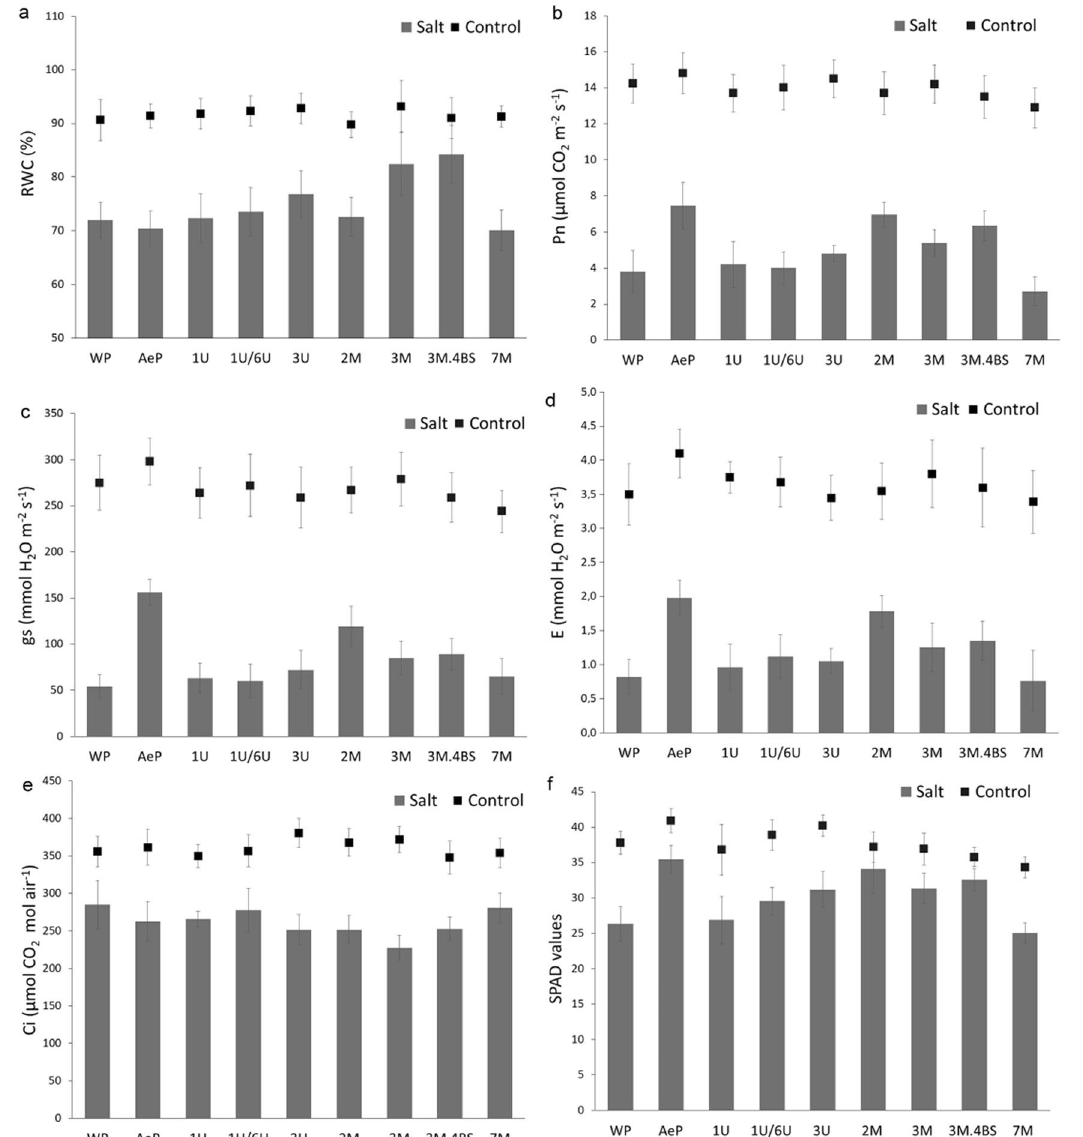
Figure 4. Relative water content (RWC) ( a ), photosynthetic activity (Pn) ( b ), stomatal conductance (gs) ( c ), transpiration rate (E) ( d ), interneccular CO2 level (Ci), ( e ) and chlorophyll content indicated by SPAD values ( f ) in leaves with and without salt treatment. WP: wheat parent; AeP: Aegilops parent. Data represent mean ± standard deviation of 5 replicates per treatment and genotype for RWC, Pn, gs, E and Ci, while n = 10 for determination of SPAD values in each treatment. The results of statistical analysis using Tukey’s post hoc test are presented in Supplementary Table 3M.4BS addition lines and the lower salt-induced changes both in the roots and in the shoots indicated a bet- ter root and shoot growth potential under salt stress condition. In the case of 2M and 3M addition lines, better growth was manifested only under salt stress conditions. Similar trends were observed for the changes of root and shoot weight (Supplementary Fig. S1). Wilting of leaves is one of the most obvious symptoms of salt-induced osmotic stress, indicating a disturbance in water balance 39 . In the present study, the RWC of the leaves was similar in all plants grown in hydroponic solution without salt stress, while RWC decreased significantly under salt stress condition in most genotypes, except for 3M and 3M.4BS addition lines (Fig. 4a). It seems that these genotypes were able to maintain the water content of the leaves under salt stress. Salinity-induced decrease in the water potential of the hydroponic solution induces stomatal closure, a decline in carbon assimilation and transpiration 40,41 . When the plants were exposed to salt stress, the decrease of CO 2 assimilation rate (Pn), stomatal conductance (gs) related to stomatal closure and transpiration rate (E) were more pronounced in the wheat than in the Aegilops parent, however, no significant difference was found between the two parental lines under control conditions (Fig. 4b–d). Without salt treatment, only the 7M addition lines